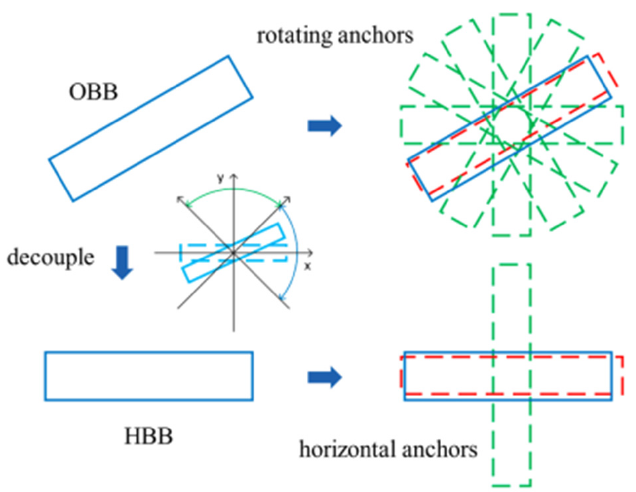
Figure 7. Matching methods of the ground truth bounding box and the rotational bounding box.